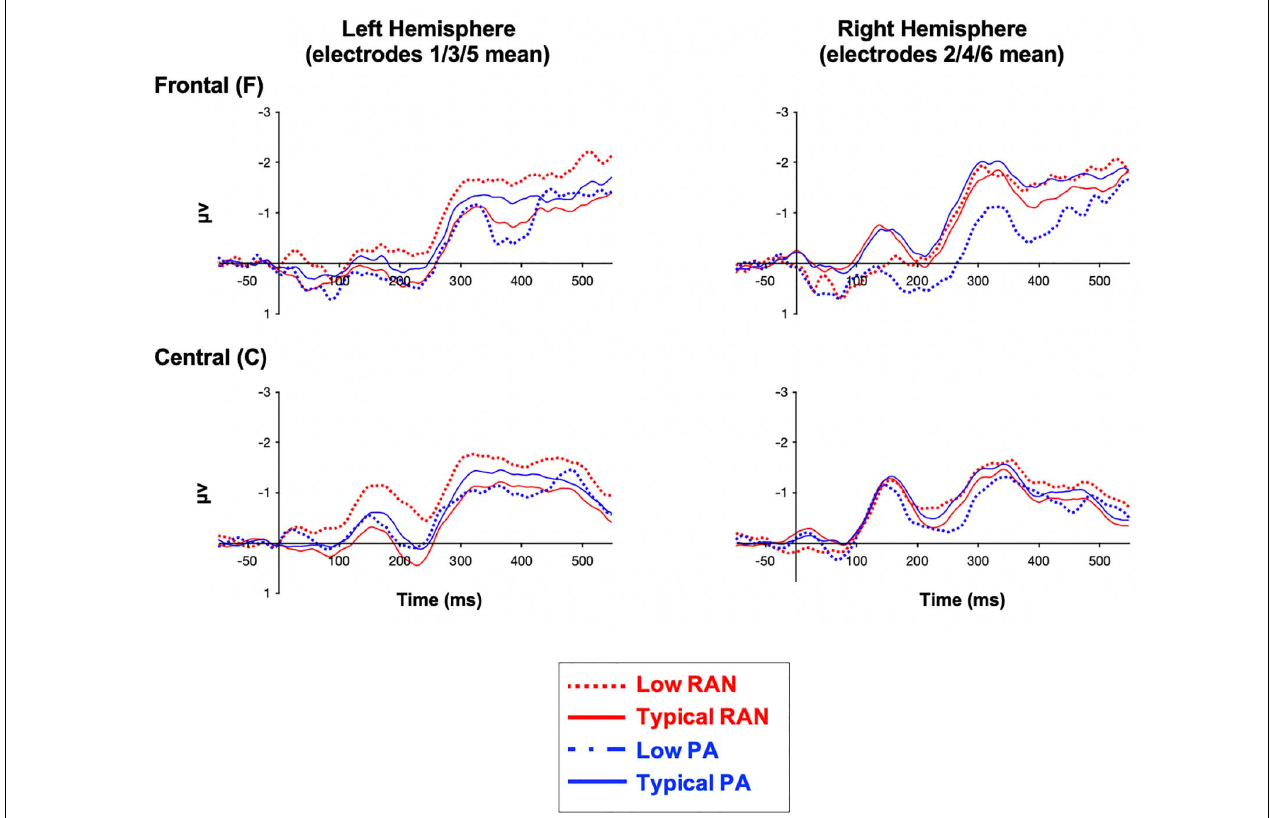
FIGURE 2 | Grand average ERP MMN waveforms (deviant-standard difference wave) by group and region of interest. Negative is plotted